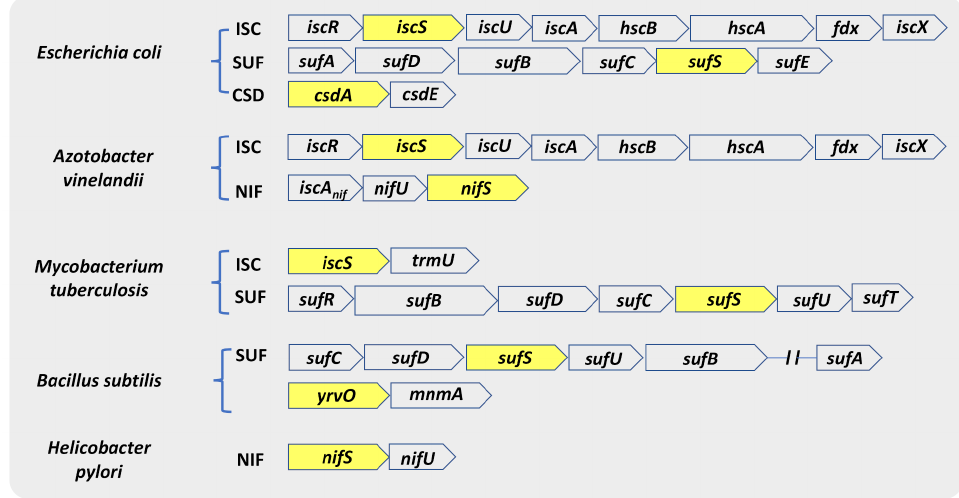
Figure 2. Genetic arrangement of ORFs coding for different classes of CSD. CSD genes in various organisms mostly remain associated with the genetic loci encoding Fe-S cluster biogenesis machinery (ISC, SUF, and NIF). The genetic map also shows that different bacterial species have evolved to harbor different combinations of Fe-S cluster biogenesis machinery. Genes indicated inside yellow boxes are the respective CSD of that